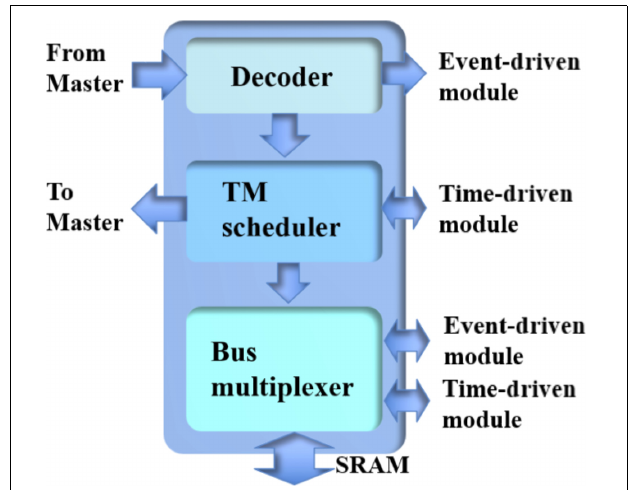
FIGURE 8 | The structure of the controller.